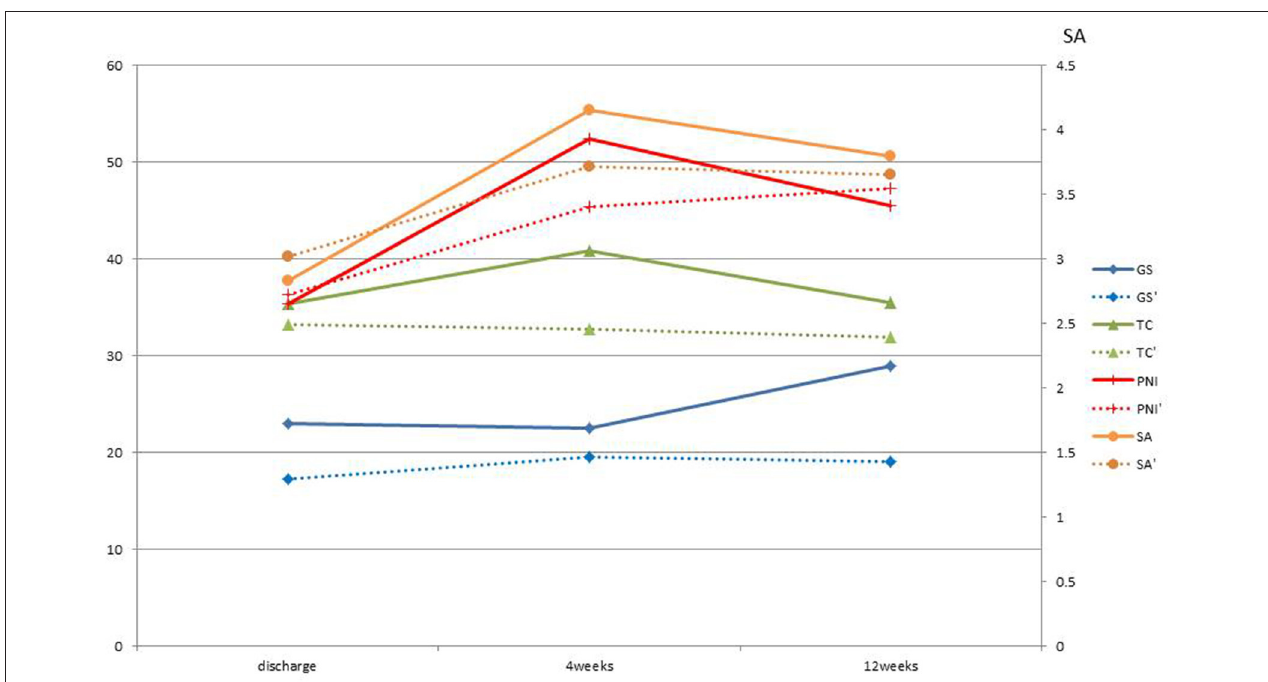
FIGURE 2 | Average change from discharge of each index with and without ninjin’yoeito. GS, Grip strength; kg; TC, Thigh circumference: cm; SA, Serum albumin; mg/dl; PNI, Prognostic Nutritional Index are the average change from discharge of the three patients who received ninjin’yoeito. GS’, Grip strength; TC’, Thigh circumference; SA’, Serum albumin; PNI’, Prognostic Nutritional Index are the average change from discharge of five patients who did not received